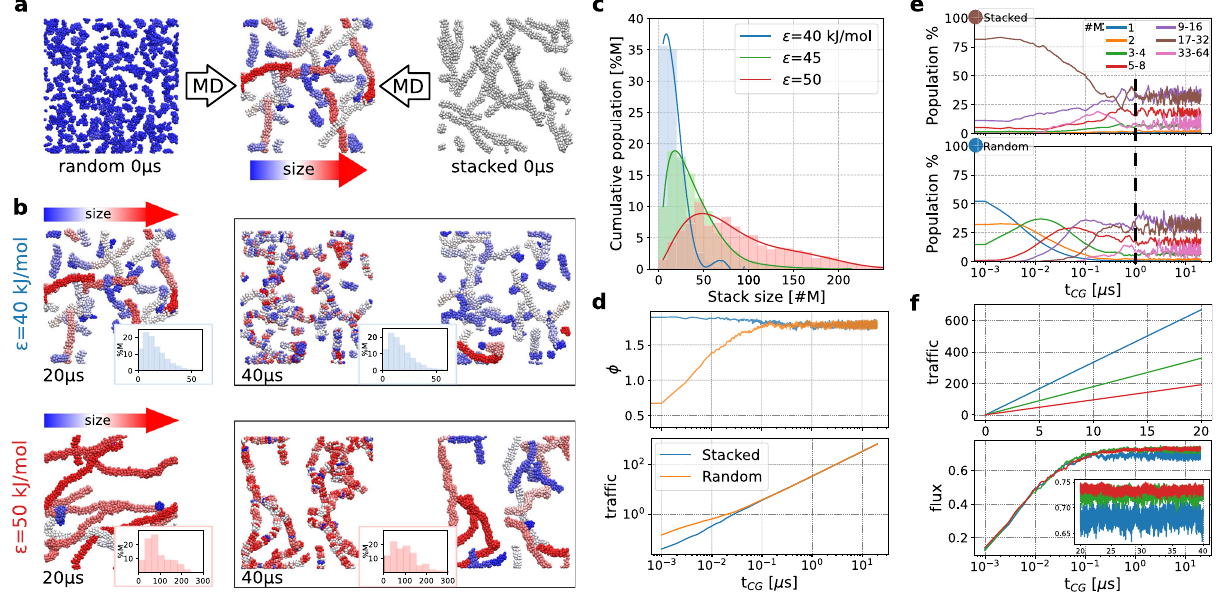
Fig. 2 Dynamic equilibrium in a minimalistic self-assembling model. a CG-MD simulations of a model system composed of 500 M monomers, starting from randomly dispersed monomers (R case, left) or monomers pre-stacked into 20 equal fi bres (S case, right). During CG-MD both systems relax to the same dynamical equilibrium state (centre: example snapshot). The assemblies are coloured based on their size (see colour bar). b CG-MD snapshots for the ϵ = 40 kJ mol − 1 (top) and ϵ = 50 kJ mol − 1 (bottom) systems. Left: snapshots at t CG = 20 μ s (assemblies coloured according to their size). Centre: snapshots at t CG = 40 μ s, where the monomer colouring used at t CG = 20 μ s (left) is preserved - the colour reshuf fl ing indicates molecular exchange after equilibrium is reached. Right: same snapshots as centre but assemblies recolored according to their current size (at t CG = 40 μ s). The relative assembly- size distributions are reported in the insets. c Average distribution of aggregate sizes for different ϵ values at the equilibrium. d Average coordination number ϕ between the M centres (top) and cumulative molecular traf fi c 55 (bottom) along CG-MD in the S and R cases. e Evolution of the assembly-size populations for the S (top) and R (bottom) cases. The brown and blue circles at t CG = 0 indicate the initial population in the two cases. After t CG = 1 μ s (vertical dashed black line) the two systems reach a comparable microscopic equilibrium state, and the populations plateau. f Molecular traf fi c and fl ux 55 vs. time at different ϵ